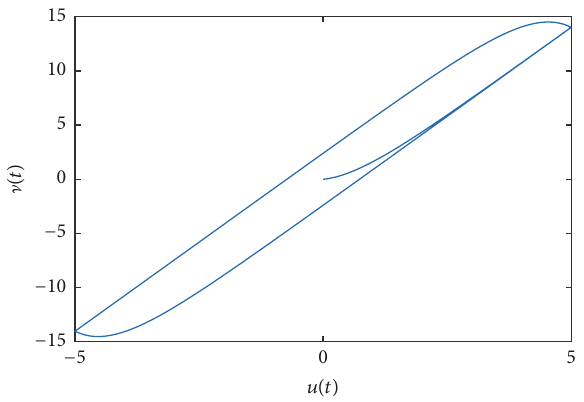
Figure 1: Hysteresis